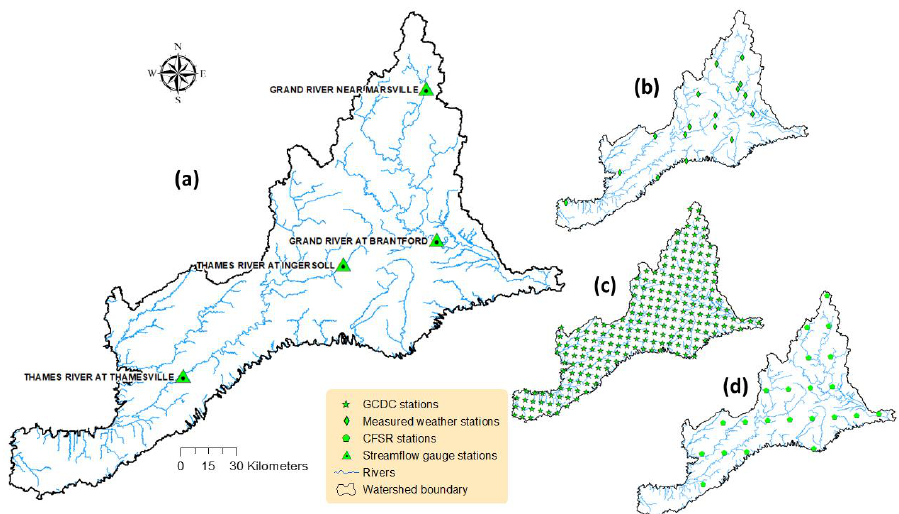
Figure 4. Three weather coverage maps of Northern Lake Erie basin with streamflow gauge stations: ( a ) Location of four (G1, G2, T1 & T2) streamflow gauge stations with drainage pattern with in study area. ( b ) Measured climatic weather data sets location. ( c ) Gridded Climate Dataset for Canada (GCDC) with resolution of 10 km gridded. ( d ) Climate Forecast System Reanalysis (CFSR) with a spatial scale of 38 km 2 resolution.